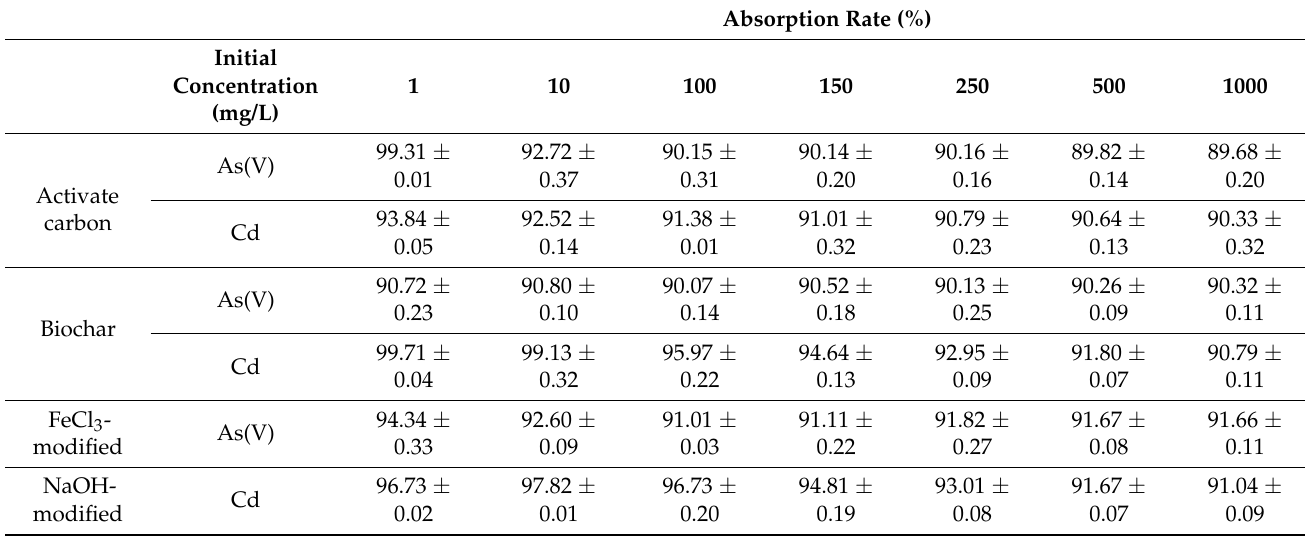
Table 3. Comparison of As(V) and Cd adsorption rates between commercially activated carbon (coconut biochar) and biochar prepared in this experiment (unmodified, FeCl 3 and NaOH modified at a calculated 800 ◦